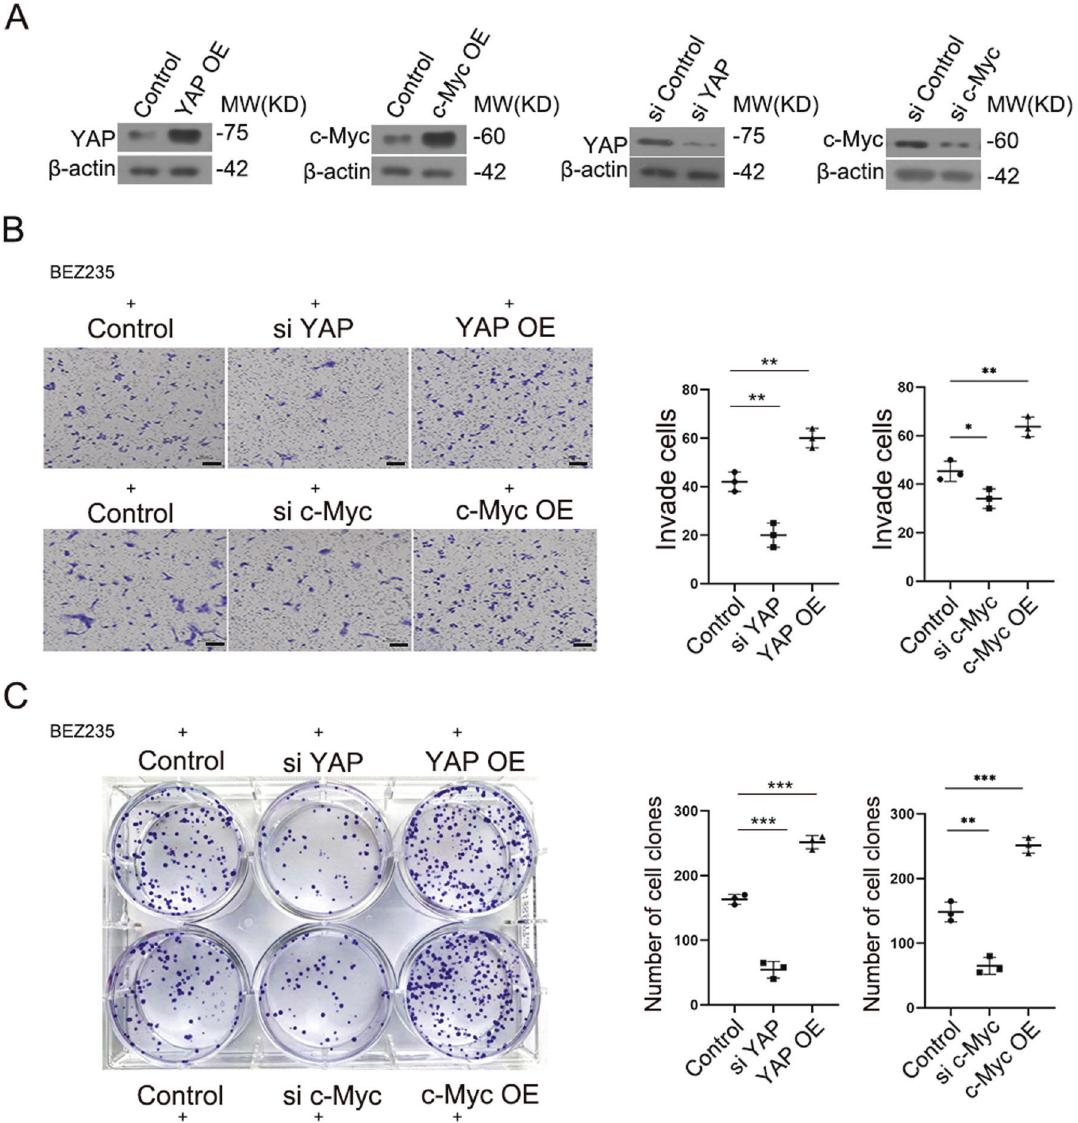
Fig. 4 YAP and c-Myc mediated resistance to the PI3K/mTOR dual inhibitor. A The protein level of YAP and c-Myc were examined in RBE cells with YAP or c-Myc knockdown or overexpression by western blot. B Transwell assay and C colony formation assay showing the